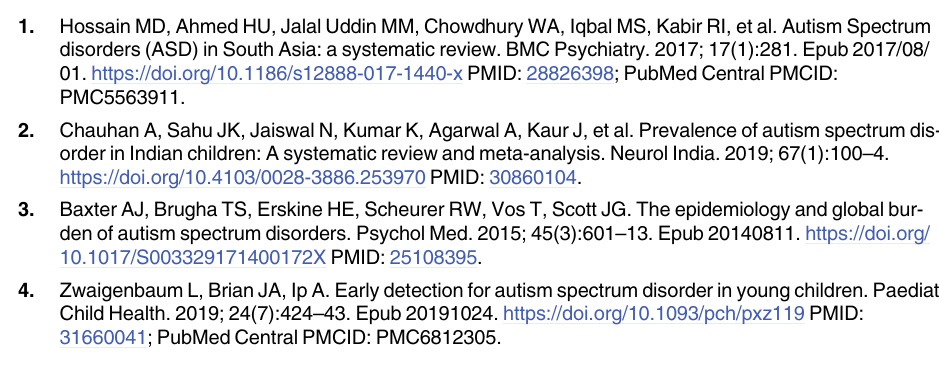
S1 Table. Sensitivity and specificity of IASQ with ISAA (n = 124). S2 Table. Sensitivity and specificity of IASQ with ISAA (n =